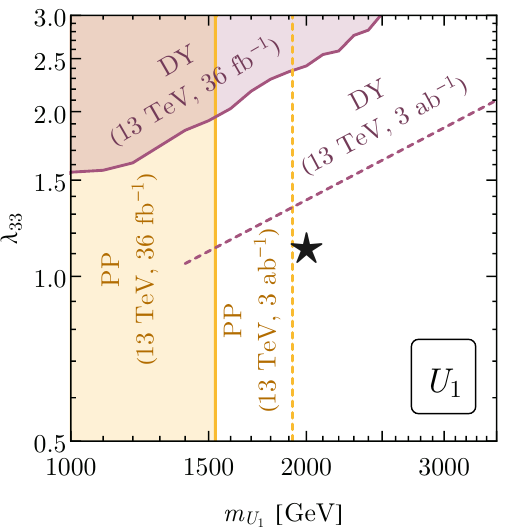
Figure 13. Current (solid) and projected (dashed) LHC constraints on the vector leptoquark U 1 mass and its coupling to the third generation quark and lepton doublets, (cid:21) 33 . The pair produc- tion and DY bounds are recast from [27] and [105], respectively. The star marks the benchmark point ( m U = 2 TeV and (cid:21) 33 = 1 : 12) from the 4321 model that explains the R 1 anomalies [123]. See text for more